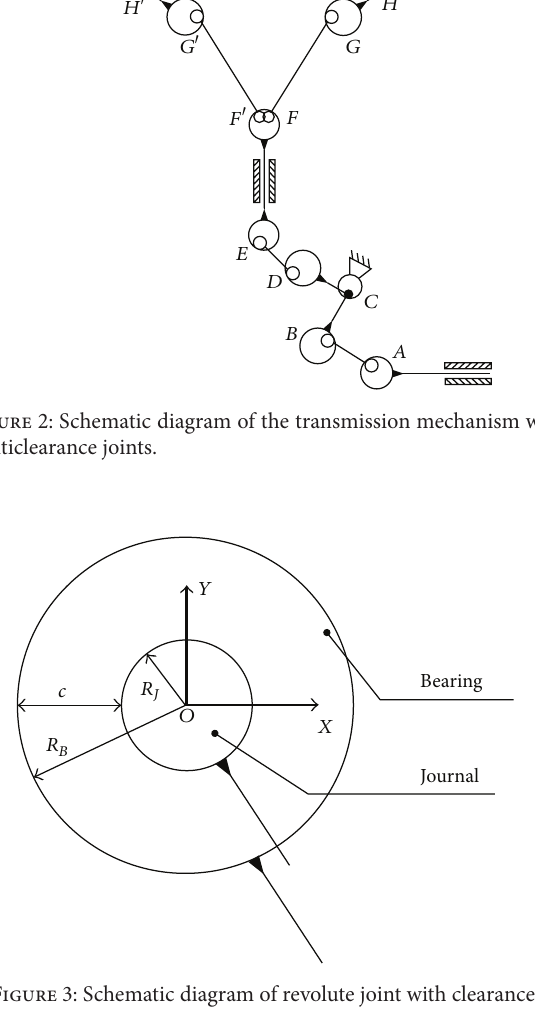
radius between the bearing and the journal represents the size of the radial